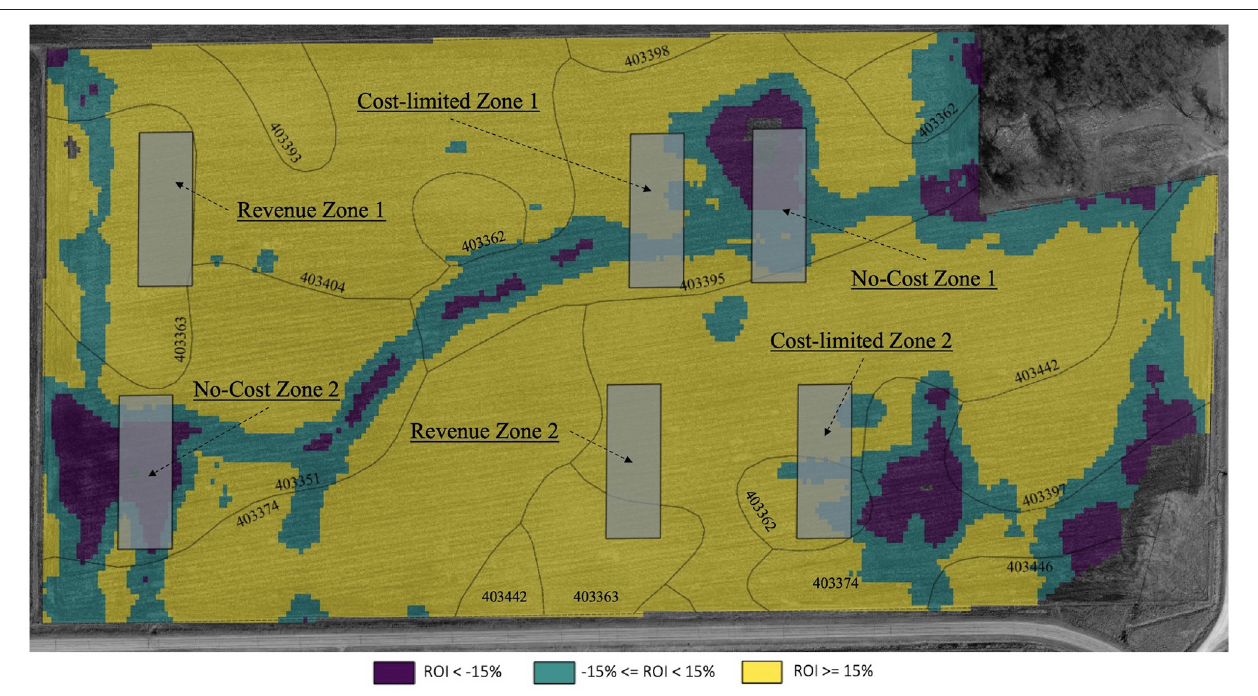
FIGURE 2 | Average 2013 and 2014 ROI map of field used to identify spatial economic zones in which N-fertilizer rate trials were performed in 2015 and 2016. SSURGO soil mapunit polygons are overlayed and labeled with unique Mukey identifier (e.g., 403442). Each soil polygon was modeled independently to determine an optimum management for that area. Boundaries defining the identified economic zones (gray areas) include two “no-cost” zones defined by an average ROI of − 15.0% or less; two “cost-limited” zones with a mean annual ROI between − 15.0 and 15.0%; and two “revenue” zones with a mean annual ROI > 15.0% (Google imagery 2017, DigitalGlobe).